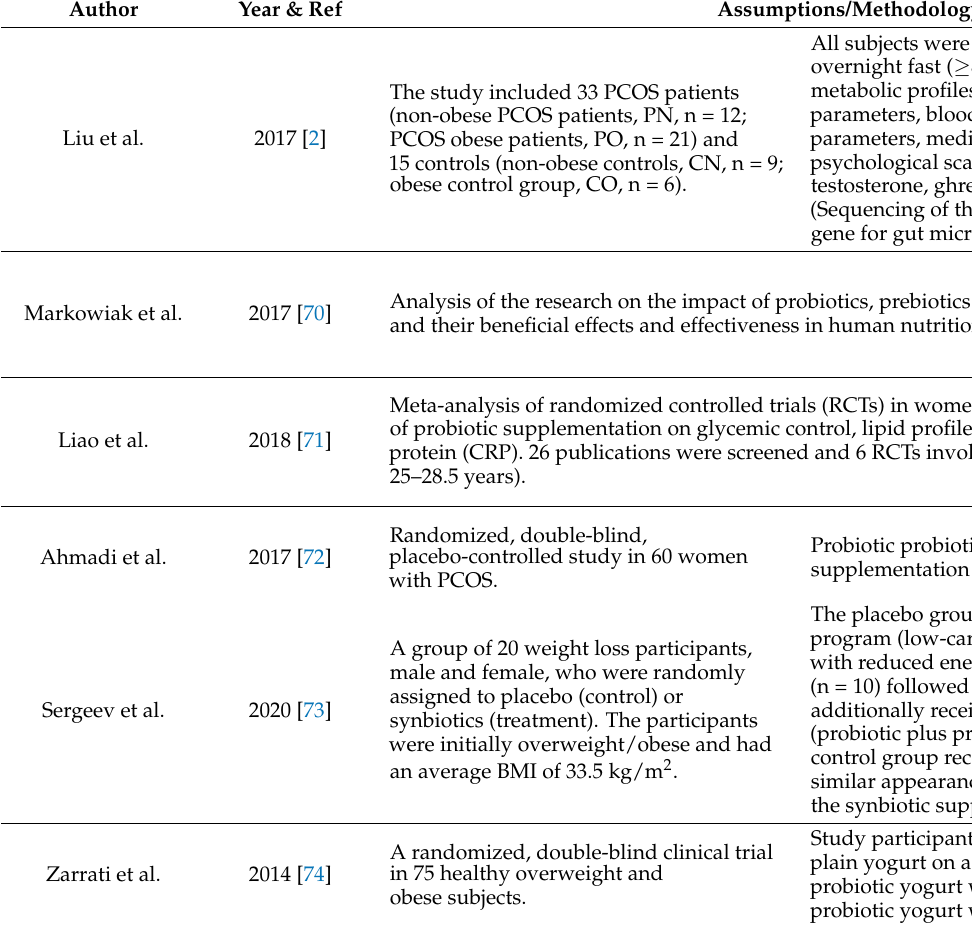
Table 6. Effects of probiotics/synbiotics in